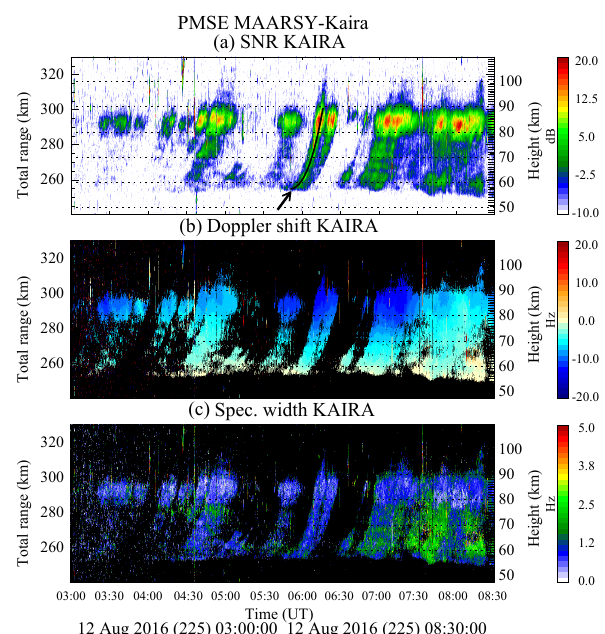
Figure 5. PMSE range–time observations using MAARSY for transmission and KAIRA for reception on 12 August 2016: (a) signal-to-noise ratio (SNR), (b) Doppler shift, and (c) spectral width. The approximate height is indicated on the right, assuming the strongest echoes are observed over MAARSY. In (a) a black line is plotted around 06:00UT over a drifting structure (pointed by a black